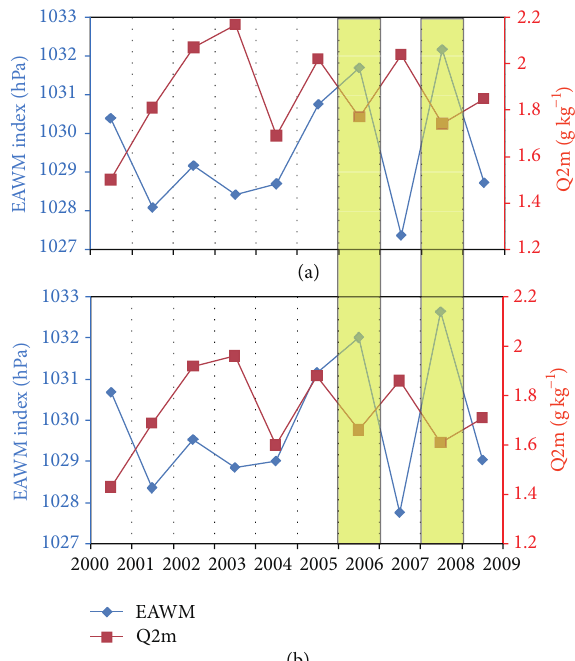
Figure 12: Year-to-year variations of the EAWM index and average winter water vapor mix ratio at 2 m above surface (Q2m) averaged in the Taklamakan Desert in Nodust experiment (a) and Dust experiment (b). The yellow columns represent strong monsoon